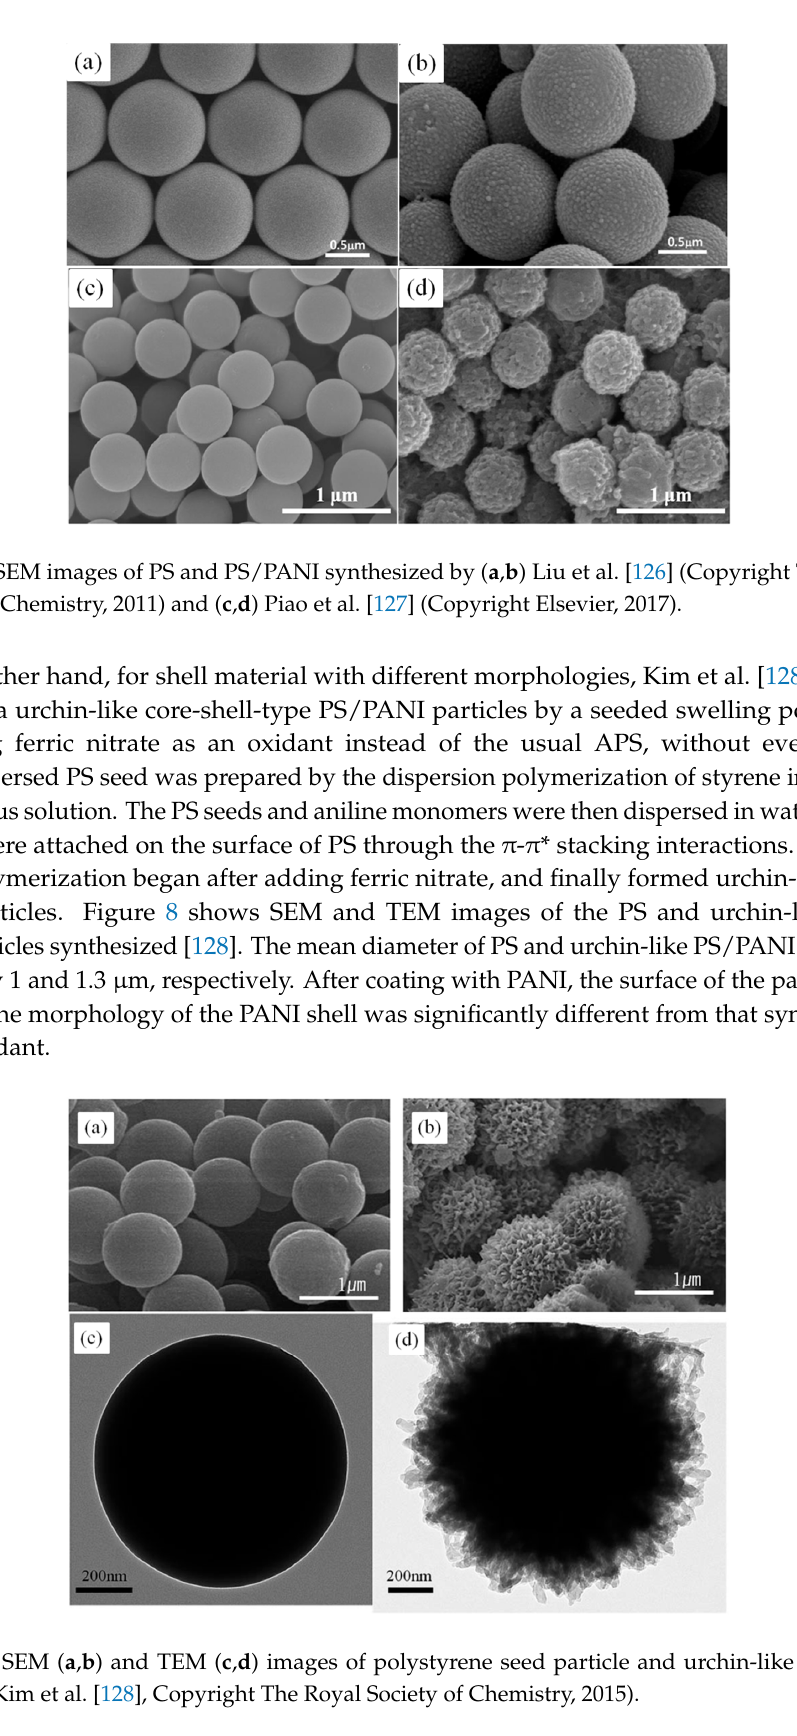
Figure 8. SEM ( a , b ) and TEM ( c , d ) images of polystyrene seed particle and urchin-like PS/PANI particle. (Kim et al. [128], Copyright The Royal Society of Chemistry, 2015).